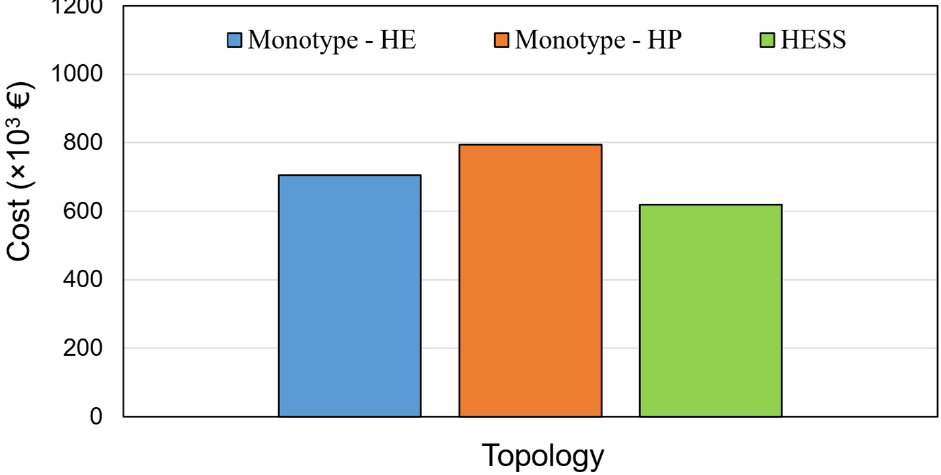
Figure 9. Cost of monotype systems and optimal HESS.